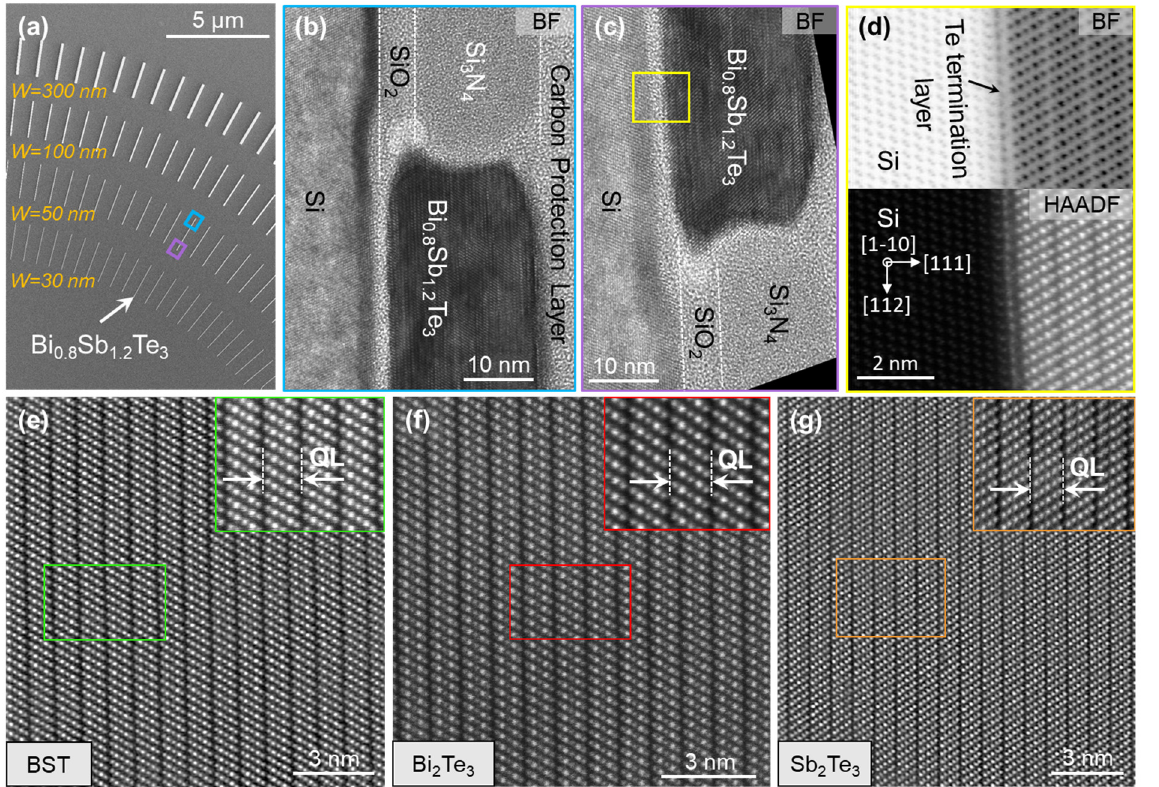
Figure 6. Dimensional dependence of R eff during SAE. ( a ) An example of BST alloy where R TF is adjusted to achieve R eff = 5 nm/h for trenches with W = 50 nm. The patterned substrate contains structures of varying sizes ( W = 30 nm, 50 nm, 100 nm and 300 nm), which results in different thicknesses for each structure. ( b , c ) Structural characterization of the BST layer cross-section via TEM where lamellae are extracted at both ends of the nanoribbon marked in ( a ). ( d ) Atomic resolution HAADF and bright field (BF) STEM images acquired at the interface between Si substrate and BST epilayer, where the presence of a Te monolayer terminating the Si dangling bonds can be observed. The HAADF images in the bulk region of ( e ) BST, ( f ) Bi 2 Te 3 and ( g ) Sb 2 Te 3 are